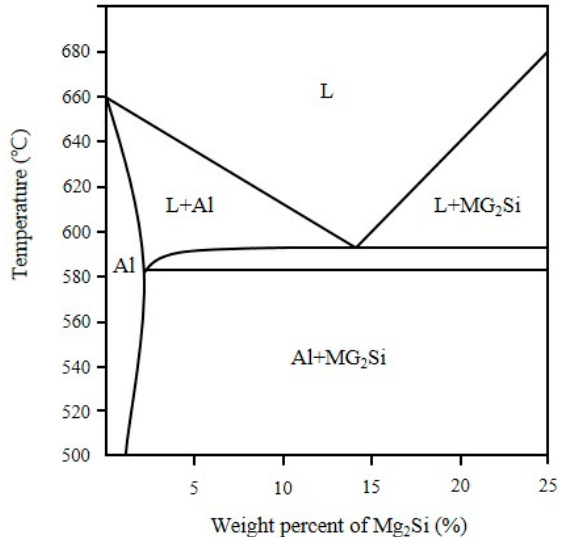
Figure 1. Calculated equilibrium phase diagram of the Al–Mg 2 Si pseudo binary section.